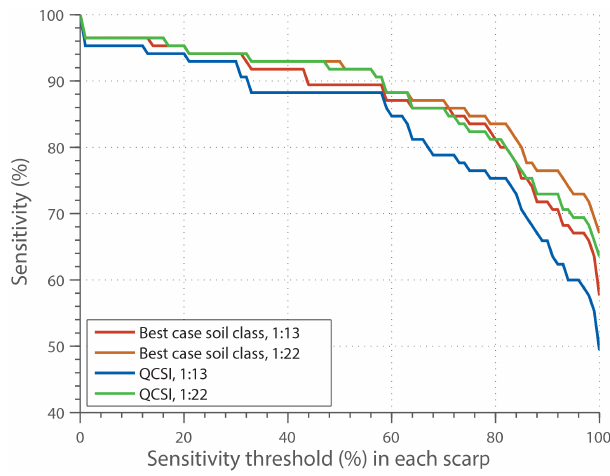
Figure 9. Threshold-based sensitivity curves of the areas prone to landslide obtained with cross-sectional angle thresholds either held constant for the best-case scenario soil class or dependent on the QCSI value. All the maps were obtained using the depth to bedrock data and were filtered.